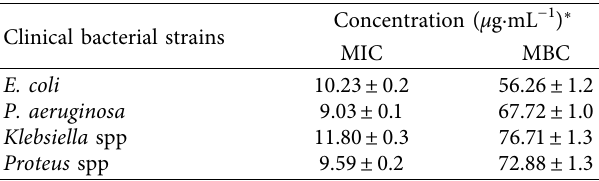
Table 2: MIC ( μ g · mL − 1 ) and MBC ( μ g · mL − 1 ) of AgNPs against the selected bacterial